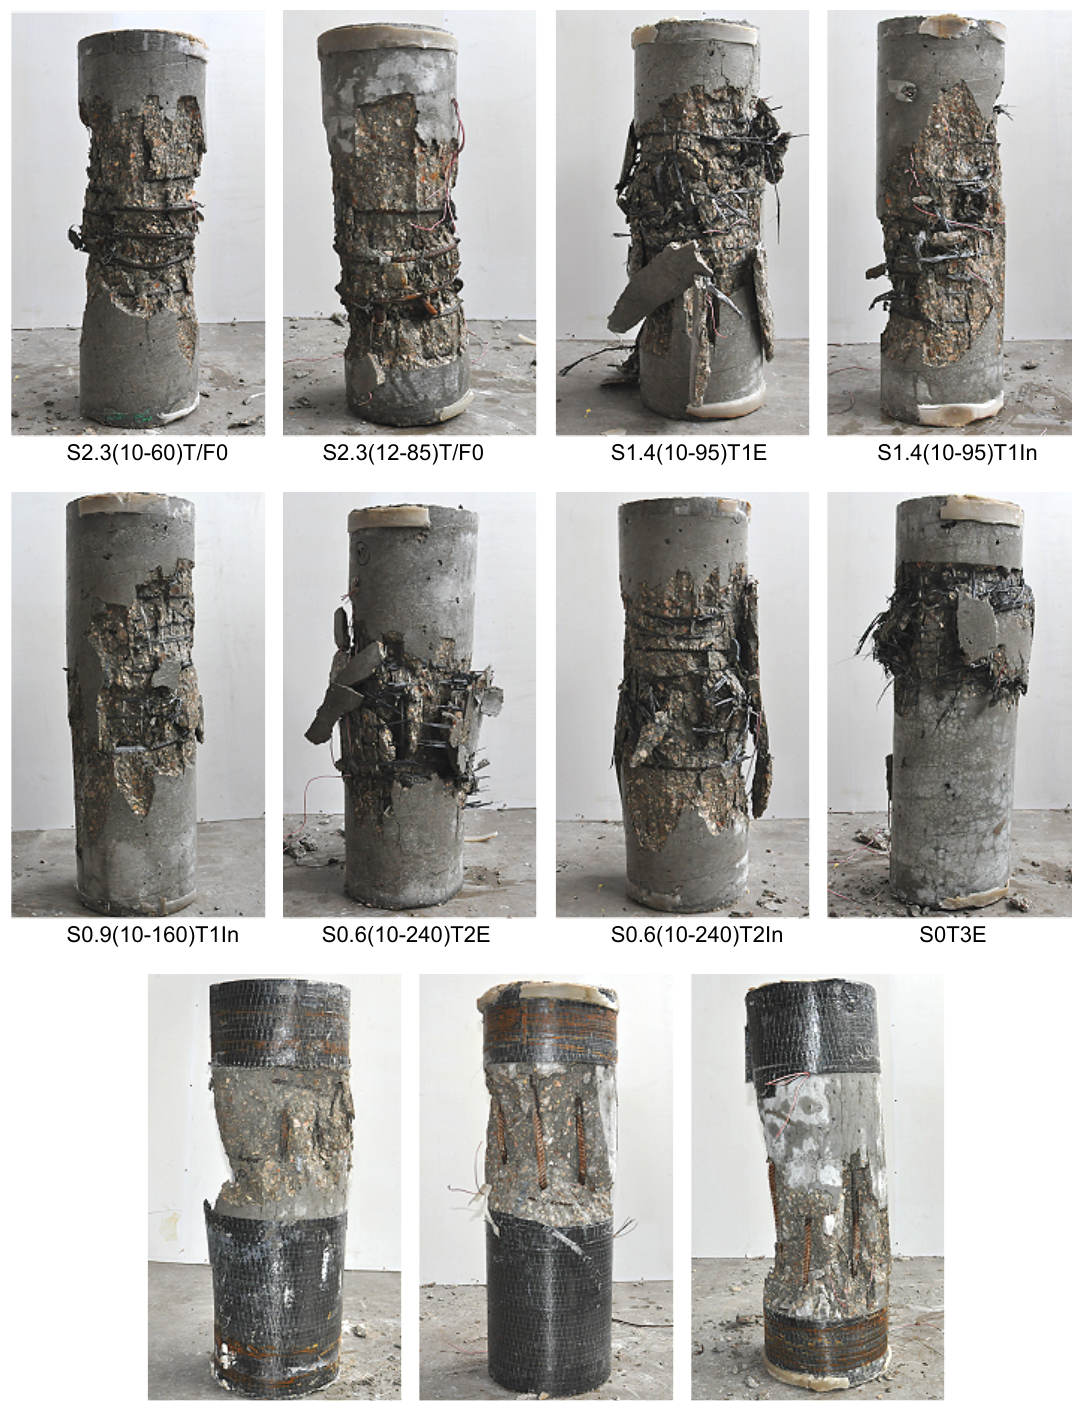
Figure 6. Specimens after